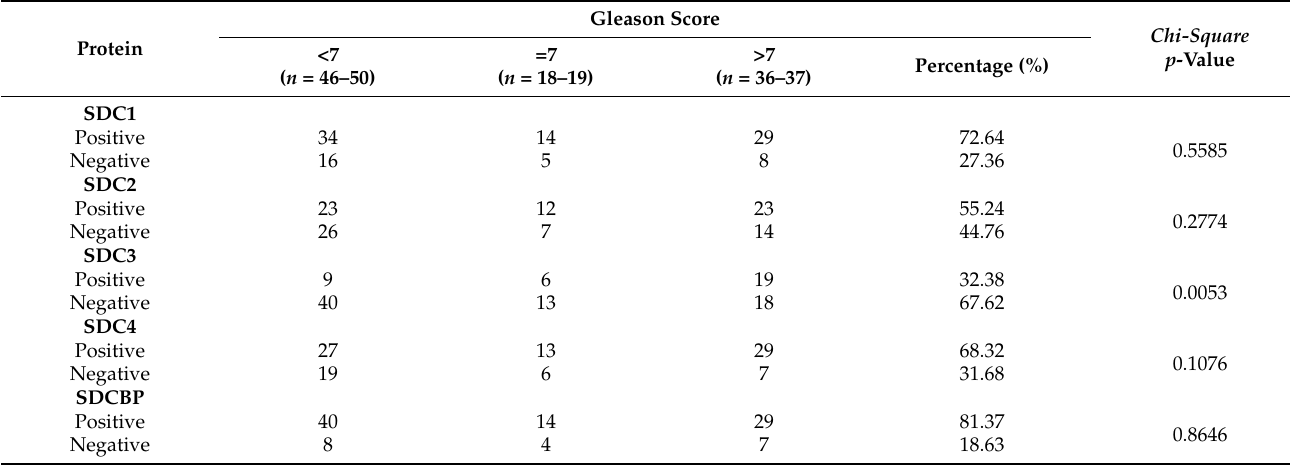
Table 1. Association between the Syndecans (SDC) 1–4 and Syntenin-1 immunostaining results and prostate cancer Gleason score 1